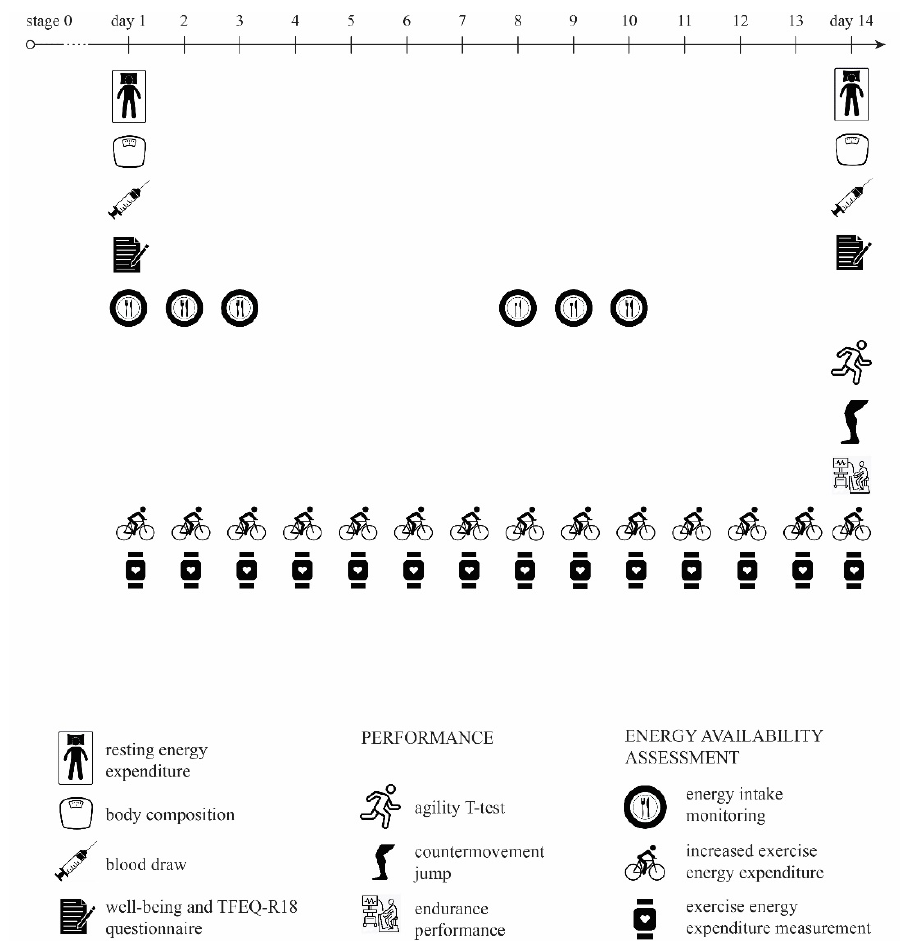
Figure 1. Study design.